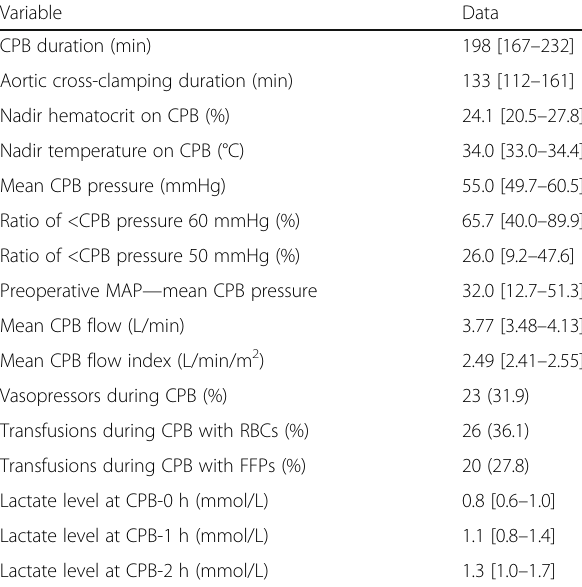
Table 1 Preoperative patient demographics Table 2 Intra-operative